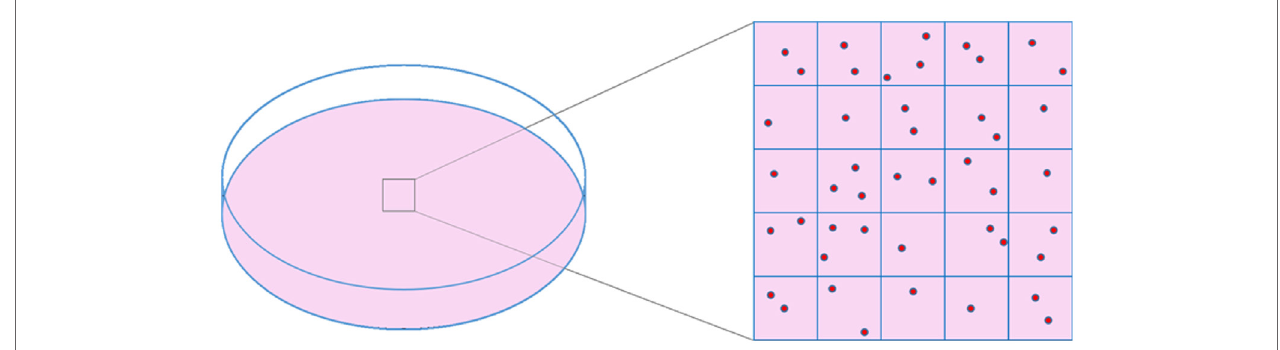
FIGURe 1 | schematic representation of cell dish area selection and virtual division of this area into frames, based on objective’s FoV size